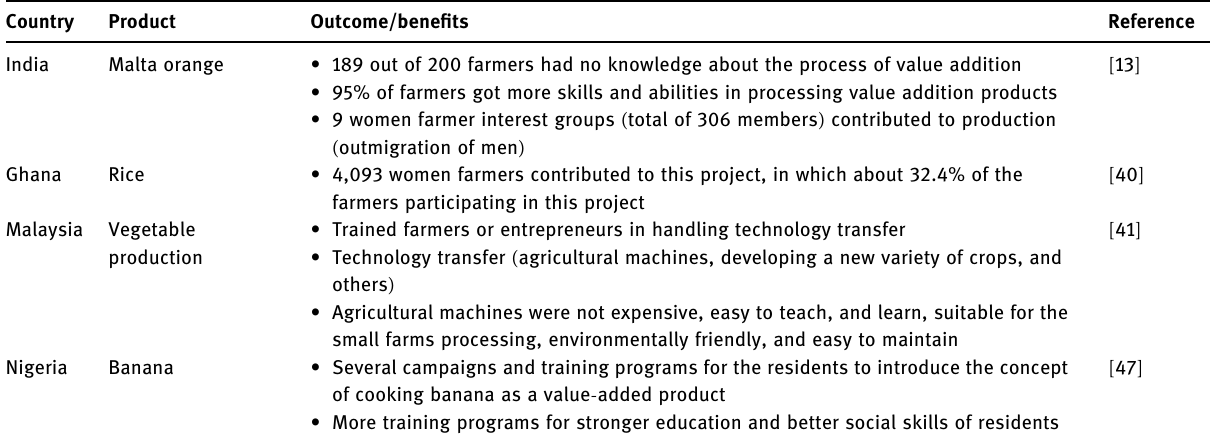
Table 4: The bene fi t of capacity building in improving the agricultural production in di ff erent countries Country